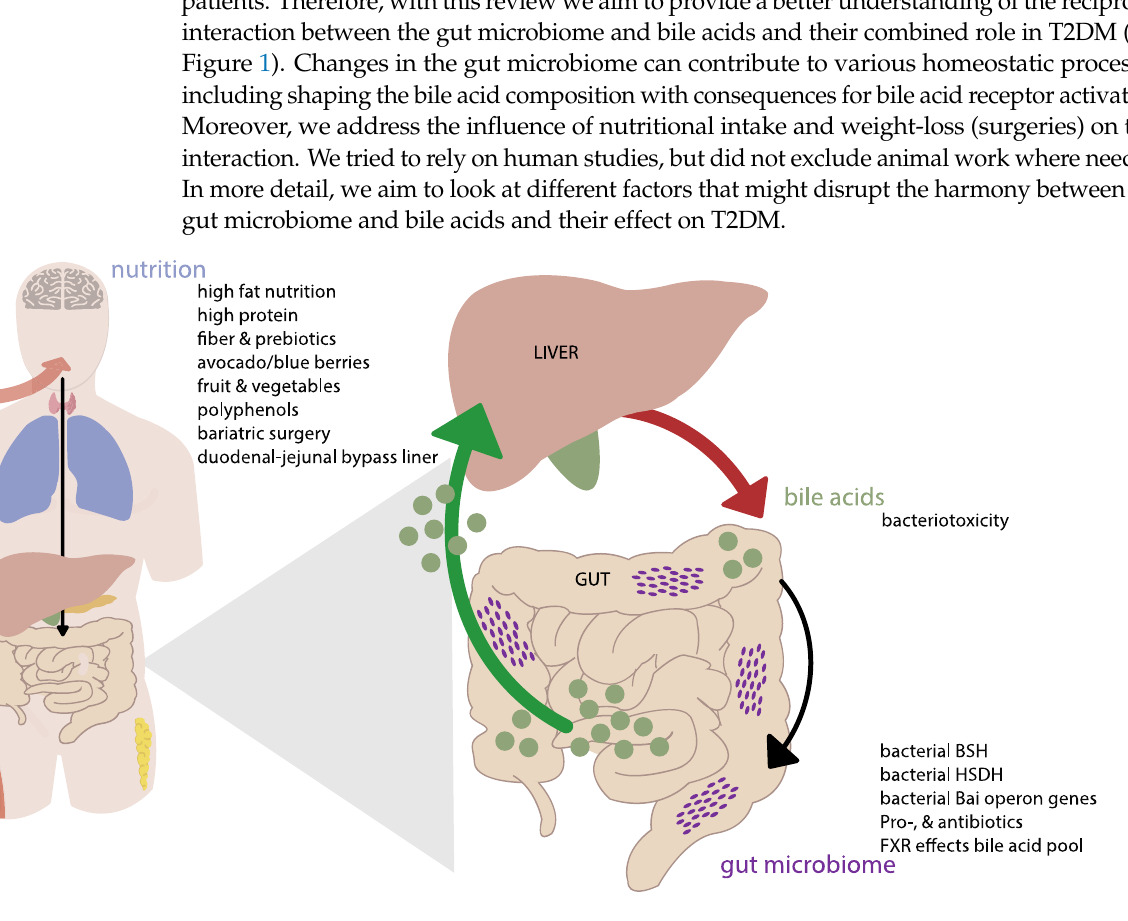
Figure 1. Conceptual scheme of the interaction between the microbiome, bile acids and nutrition. Mechanisms are described in detail in the text. Abbreviations: BSH, bile salt hydrolase; HSDH, hydroxysteroid dehydrogenase; Bai, bile acid inducible; FXR, Farnesoid X receptor.